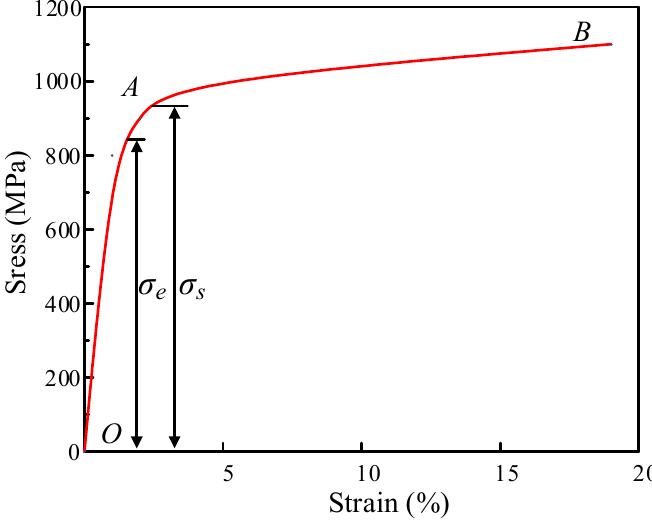
Figure 3. The true stress–strain curve of TC4.